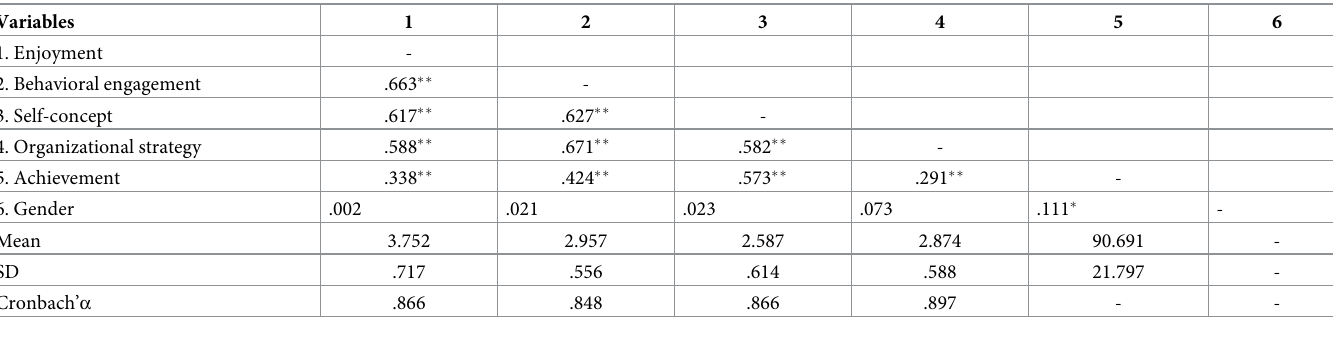
Table 1. Descriptive statistics and zero-order bivariate correlational coefficients among the variables ( N = 528). Variables